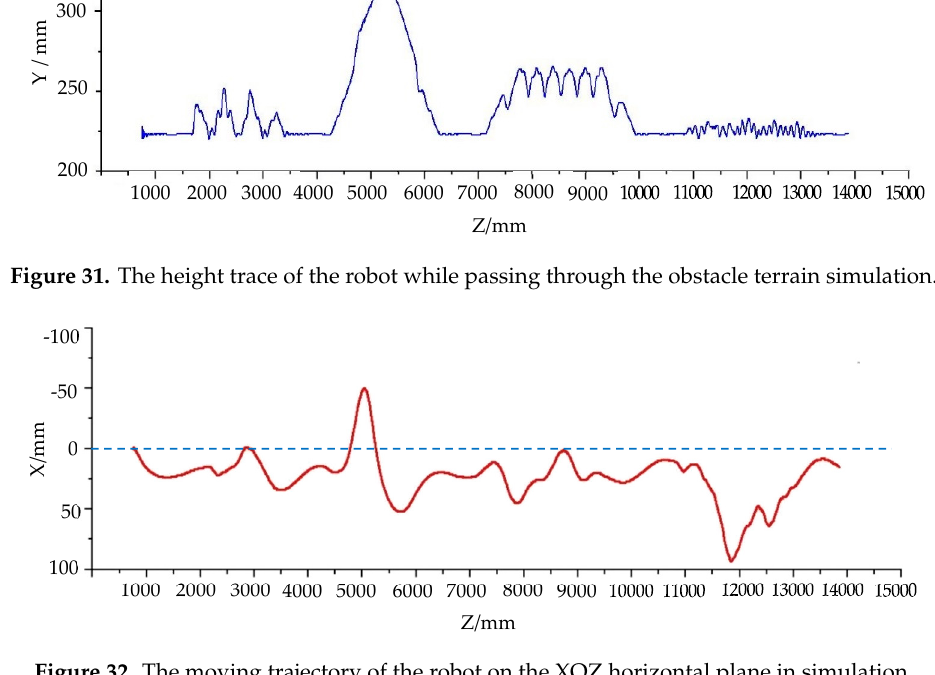
Figure 32. The moving trajectory of the robot on the XOZ horizontal plane in simulation.